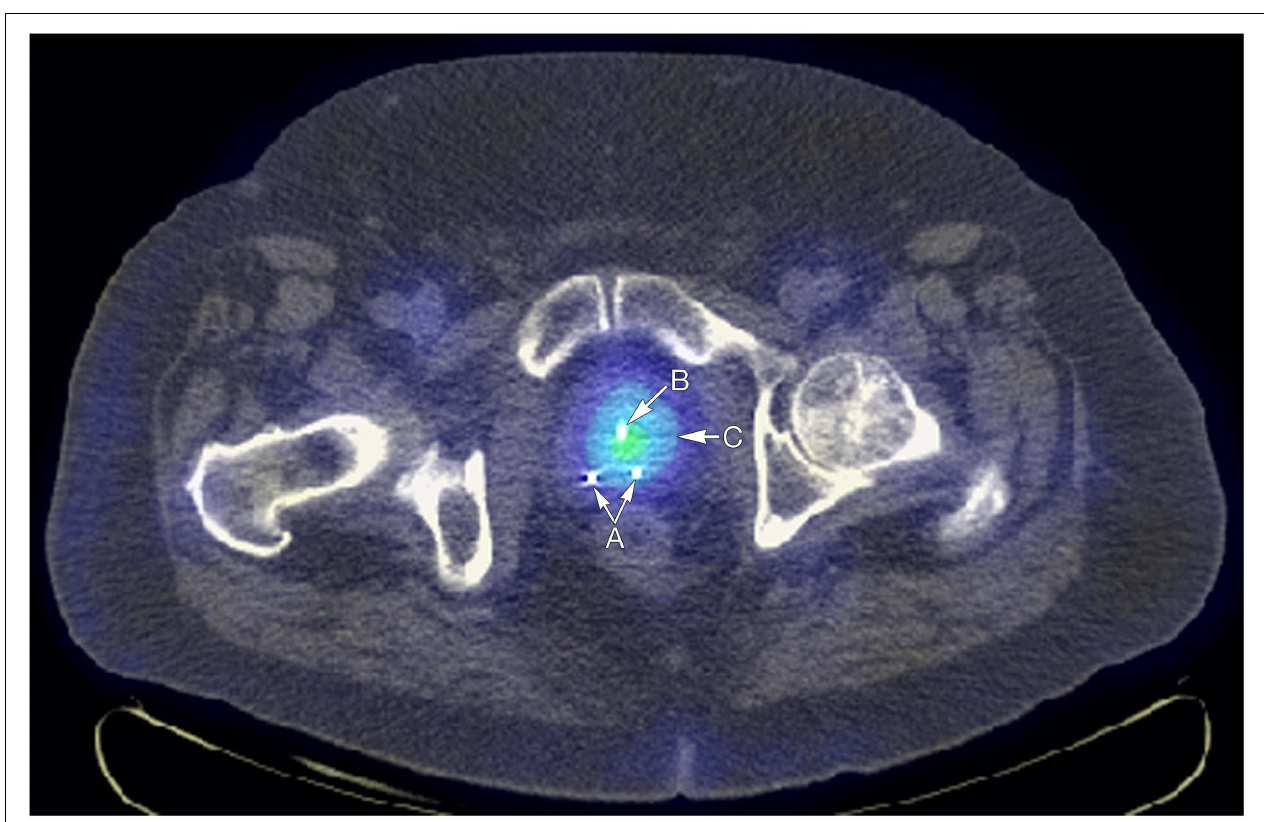
FIGURE 3 |ArrowA points to fiducial markers for external beam radiotherapy image guidance, arrow B points to Foley catheter, and